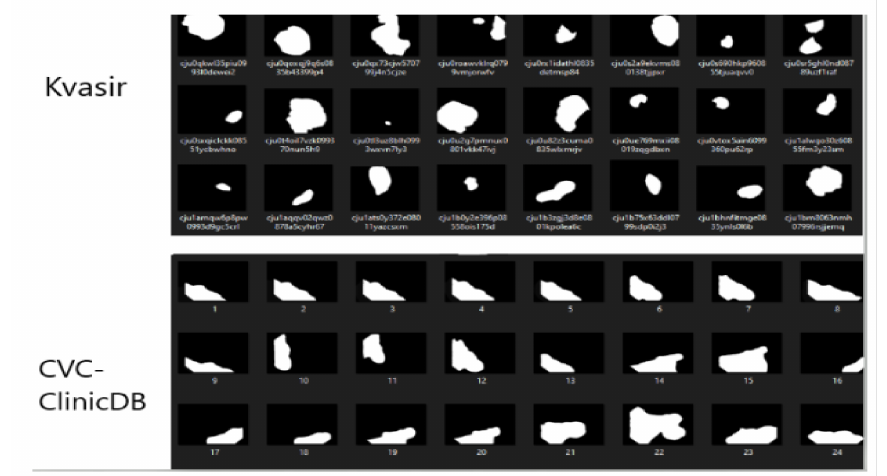
Figure 14. Comparison between different masks of the used dataset.